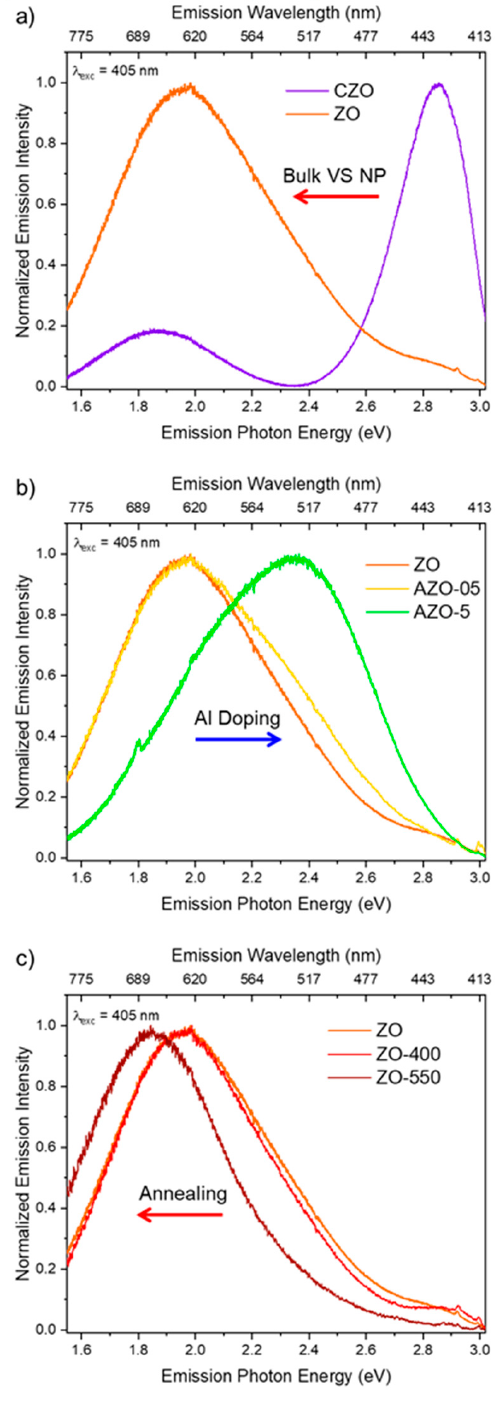
Figure 5. Normalized PL spectra of all samples excited at 405 nm. Comparisons among commercial (bulk) and ZnO nanoparticles ( a ), different Al-doping percentages ( b ), and annealing temperatures ( c ) are